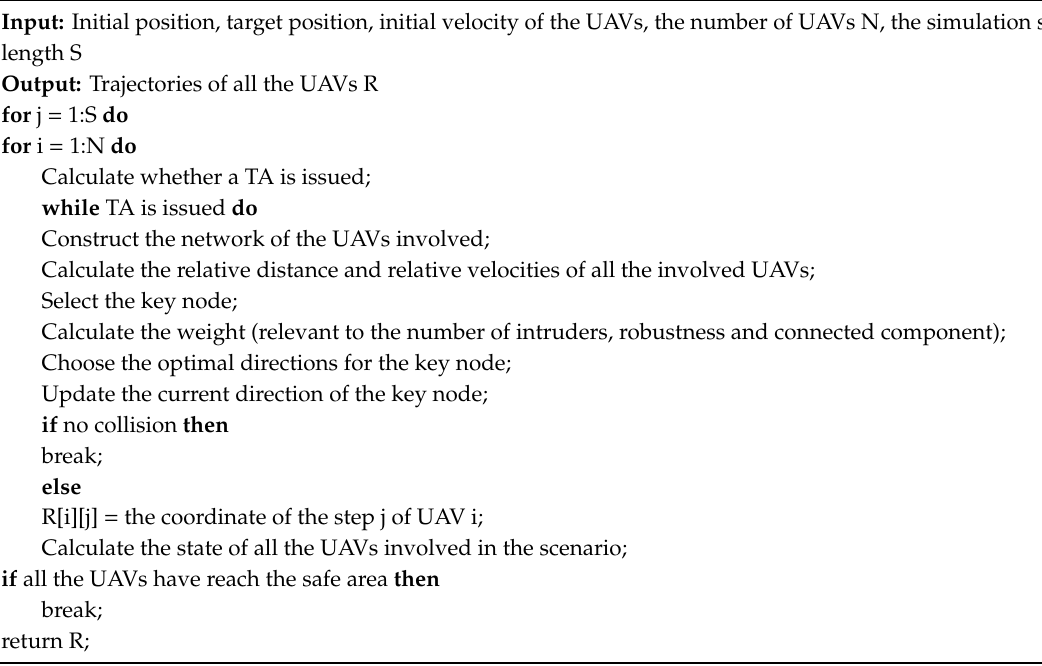
Algorithm 1 Novel Model Based on Key Node